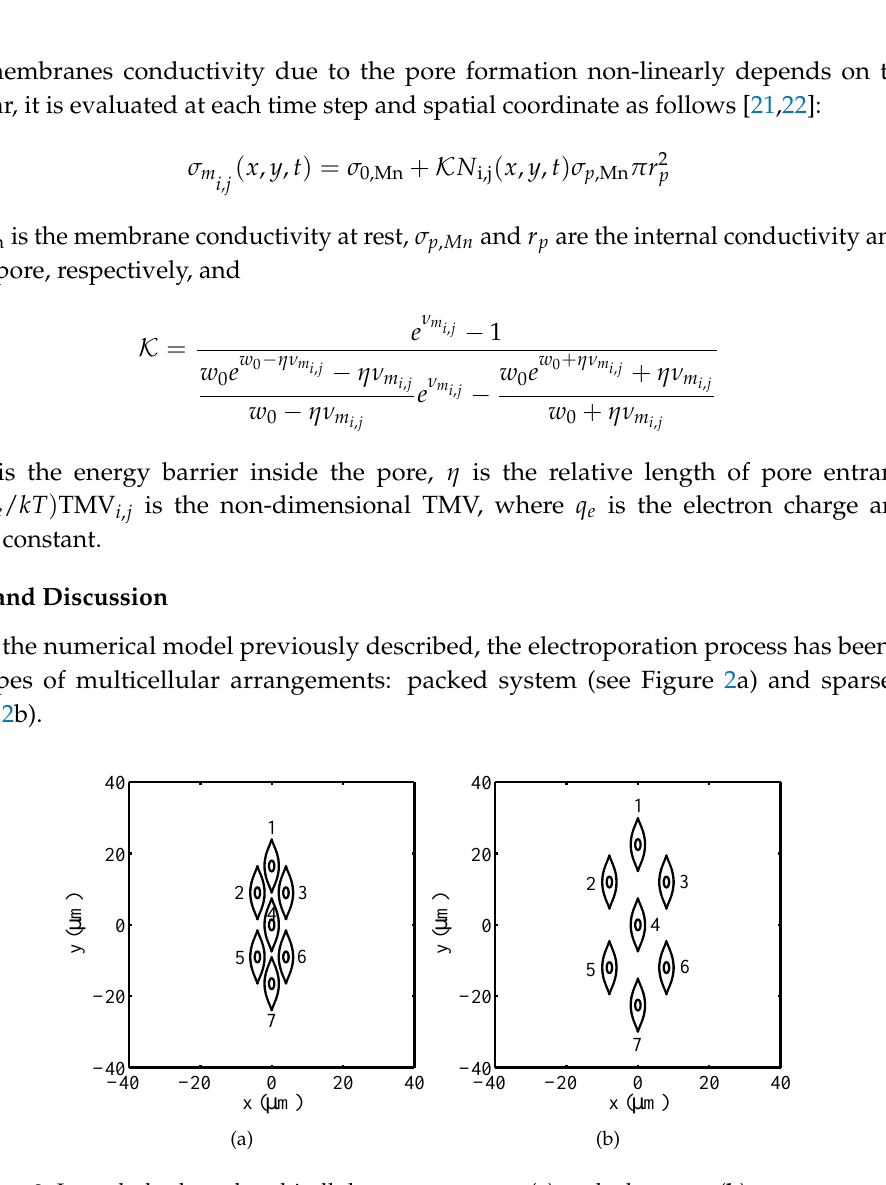
Figure 2. Irregularly shaped multicellular arrangements: ( a ) packed system, ( b ) sparse